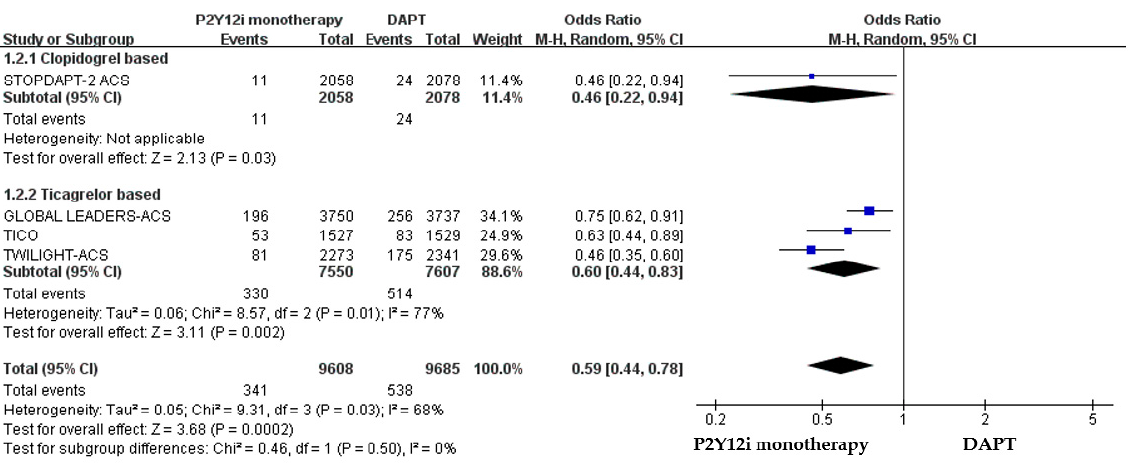
Figure 3. The efficacy outcomes (MACCE) of different P2Y12 inhibitor monotherapy as compared with 12-month DAPT in patients with ACS after PCI.